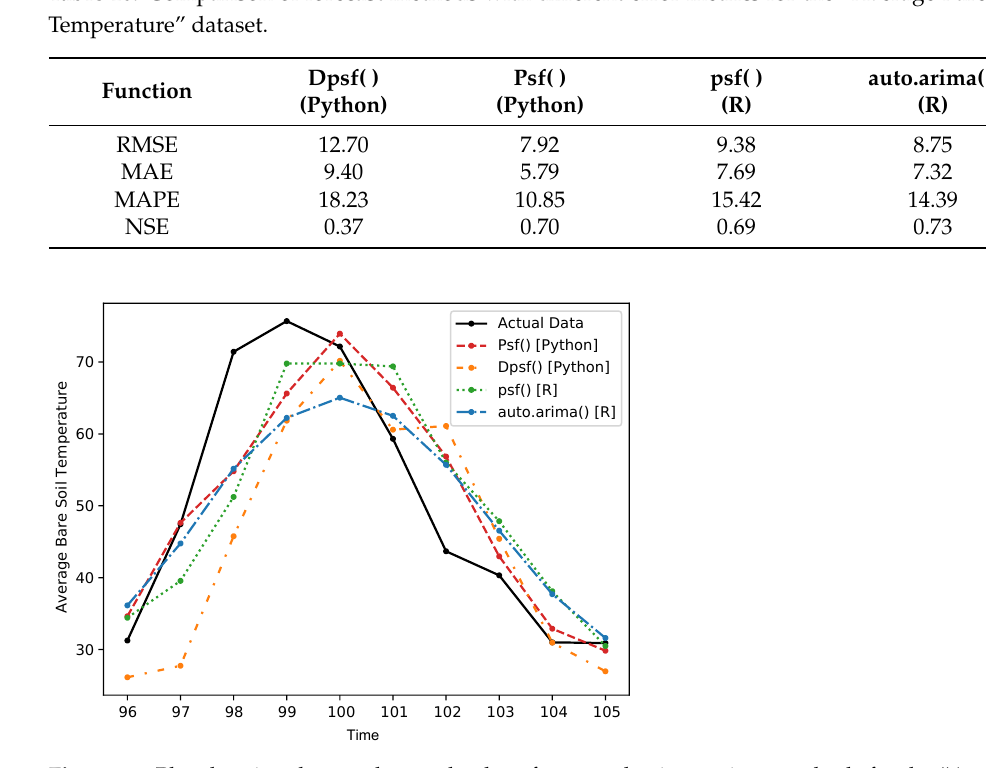
Figure 15. Plot showing the test data and values forecasted using various methods for the “Average Bare Soil Temperature”